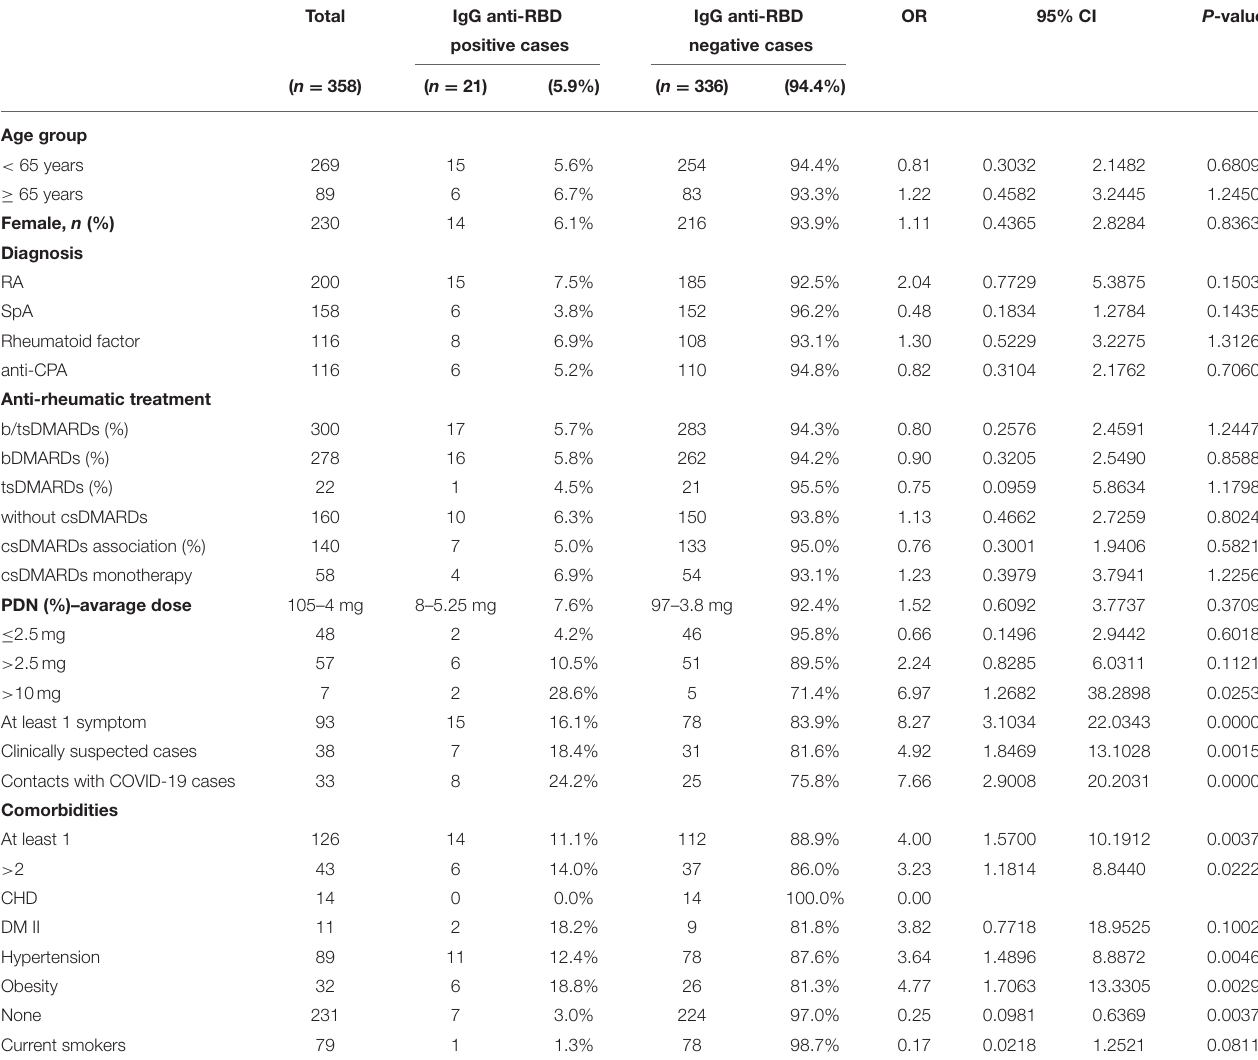
TABLE 3 | IgG Anti-RBD SARS-CoV-2 seroprevalence and associated